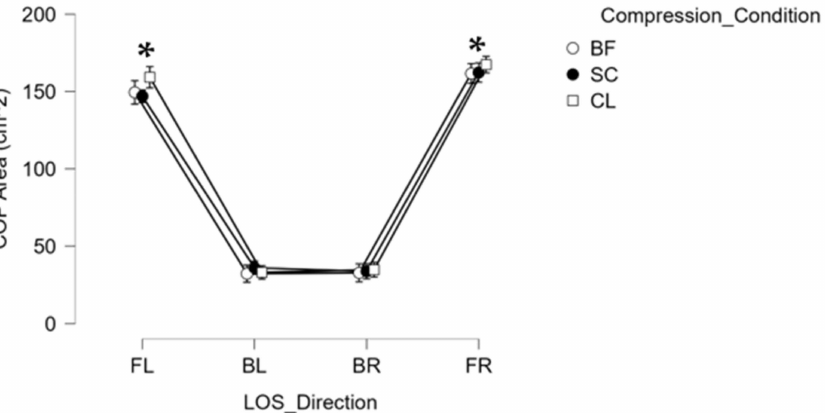
Figure 3. Center of pressure (COP) sway area (cm 2 ) during the limits of study (LOS) test in four directions; front left (FL), back left (BL), back right (BR), and front right (FR) in three compression conditions: barefoot (BF), sub-clinical compression sock (SC) and clinical compression sock (CL). * represents significant differences, and bars represent standard